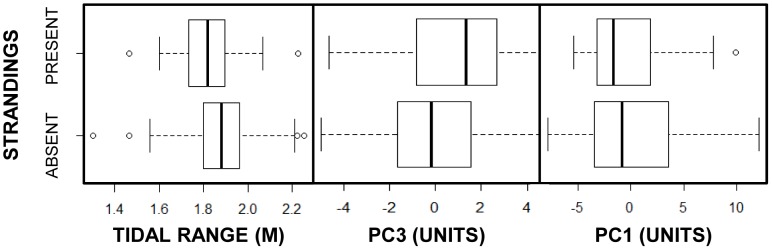
Important model factors for the occurrence of Danish west coast fresh porpoise strandings, 2003–2008.Identified by AIC, these factors were tidal range (m), PC3, and PC1 (in order added into the model). The bold lines represent median values, the boxes are 25th to 75th percentiles and the whiskers extend to the most extreme data within 1.5 IQR (interquartile range) of these lower and upper quartiles. Outliers are represented by points. PC1 & PC3 are products of the PCA and are, thus, unit-less.